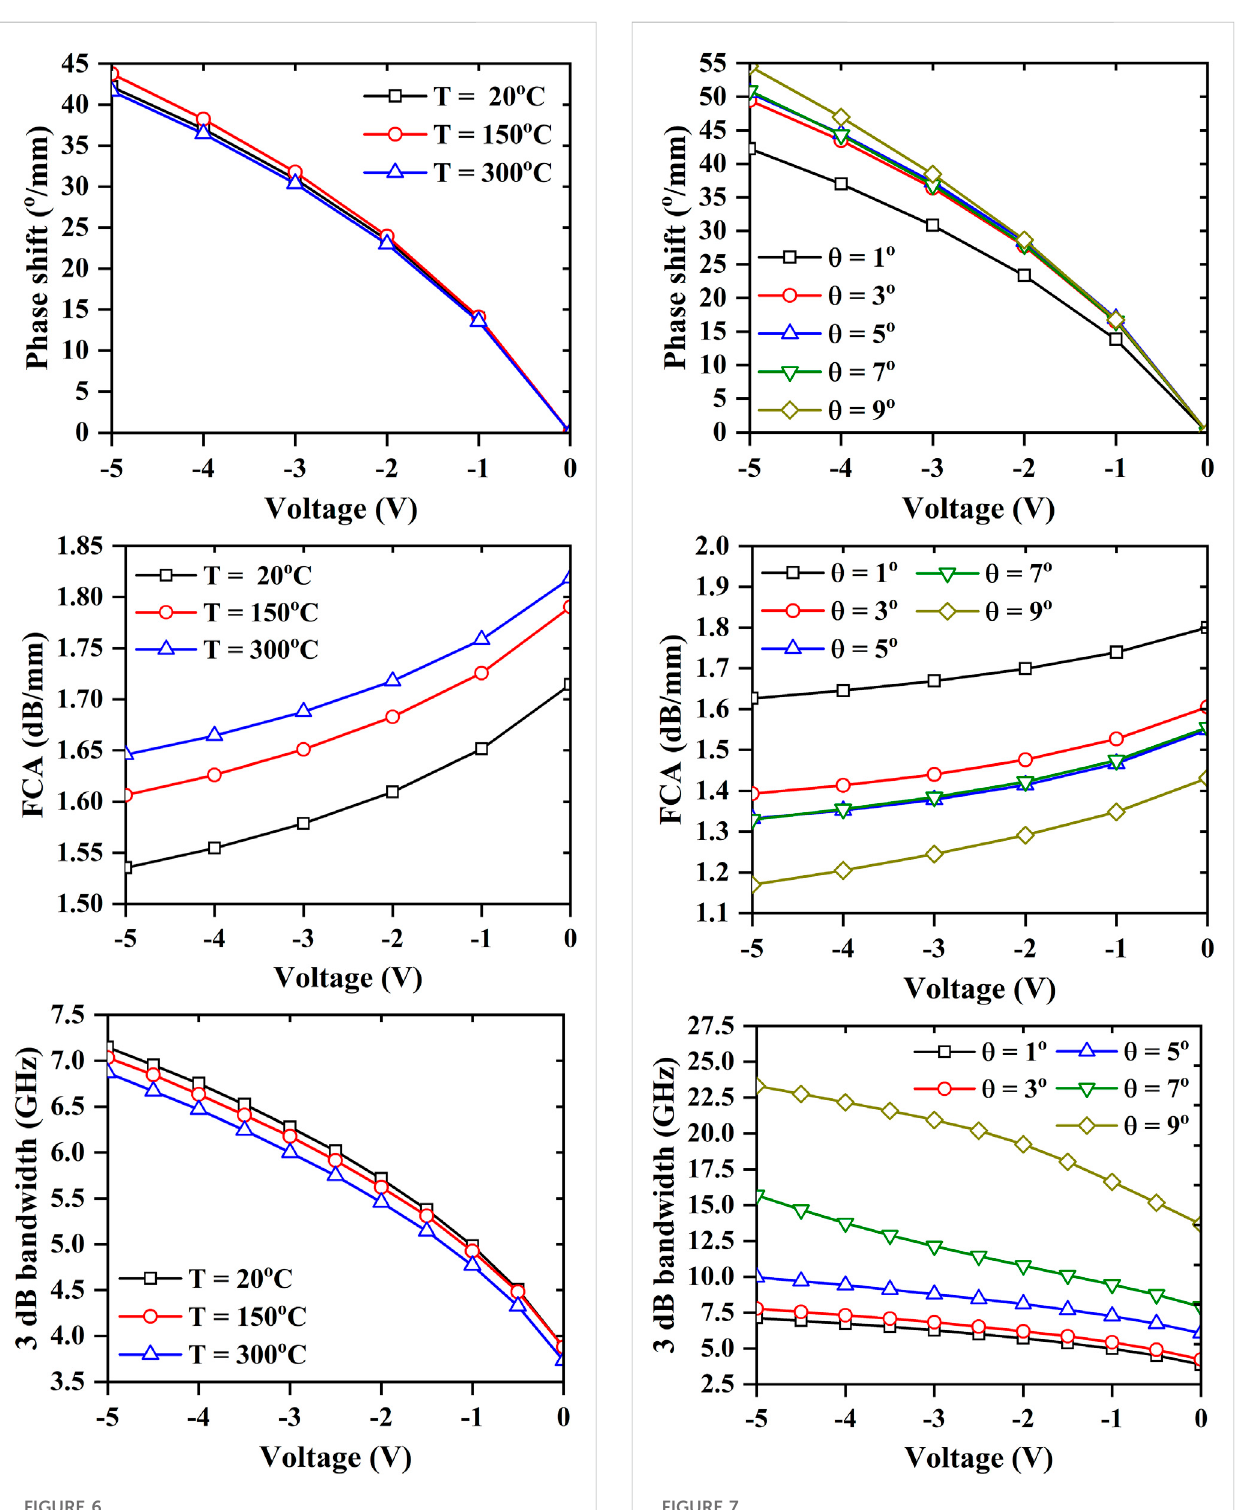
FIGURE 6 (A) Phase shift per unit length, (B) free-carrier absorption per unit length, and (C) 3-dB bandwidth for different wafer temperatures.